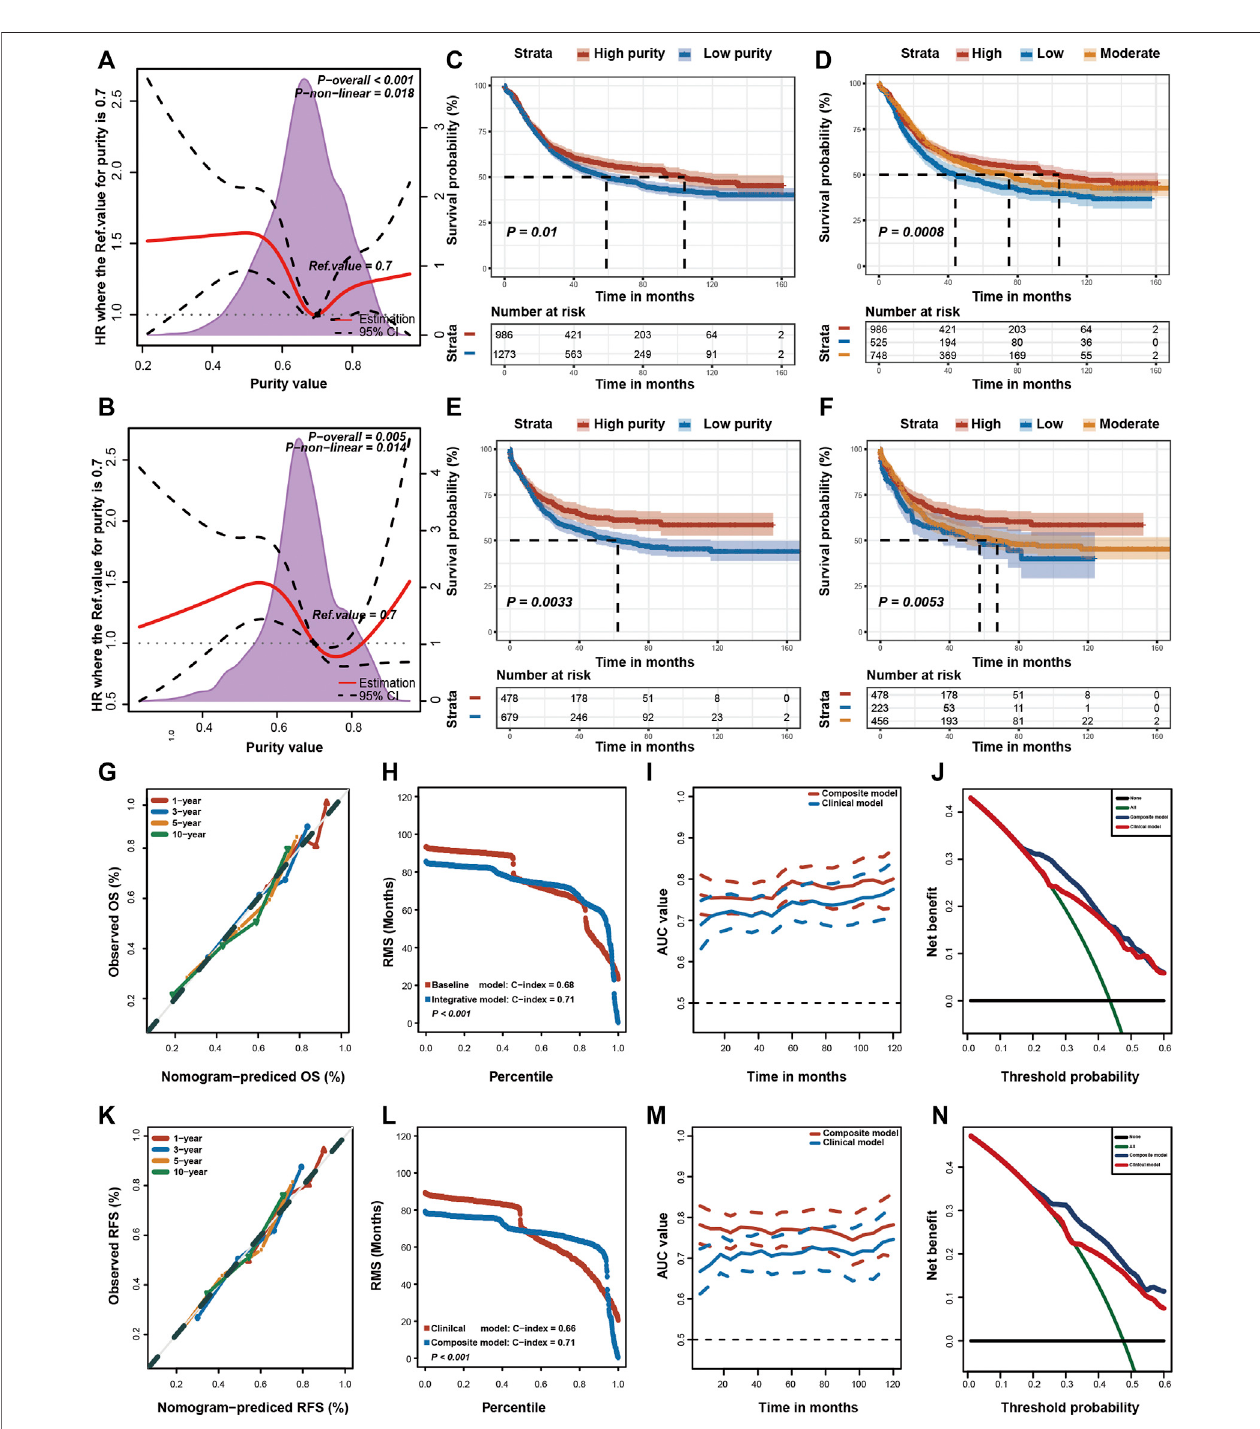
FIGURE3| Prognosticvalueoftumourpurityingastriccancer. (A,B) Associationoftumourpurityand (A) overallsurvival(OS)and (B) recurrence-freesurvival(RFS) estimated using restricted cubic splines. (C – F) Kaplan – Meier curves for (C,D) OSand (E,F) RFS among different subgroups. p -values were obtained using the log-rank test. The + symbols in the panels indicate censored data. (G,K) Calibration plots of the nomogram for the predicted (G) OS and (K) RFS at 1, 3, 5, and 10 years. (H,L) Restrictedmeansurvival(RMS)timecurvesfor (H) OSand (L) RFS. (I,M) Time-dependentROCcurvesfor (I) OSand (M) RFS. (J,N) Decisioncurveanalysisforthe prediction of (J) OS and (N) RFS using the nomogram. HR, hazard ratio.